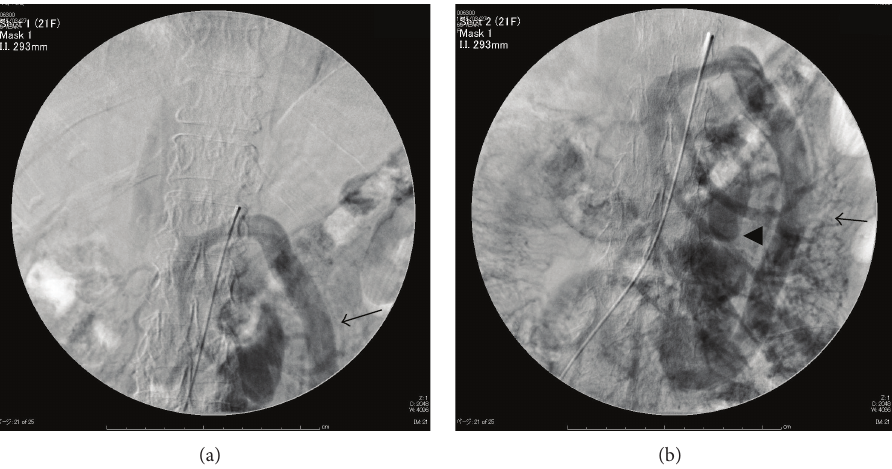
Figure 1: (a) Superior mesenteric arterial portogram shows hepatofugal giant mesocaval shunt (arrow). Portal vein was not visualized. (b) Superior mesenteric arterial portogram: mesenteric venous blood was drained into the inferior vena cava via dilated inferior mesenteric vein (arrow), left ovarian vein (arrowhead) and left renal